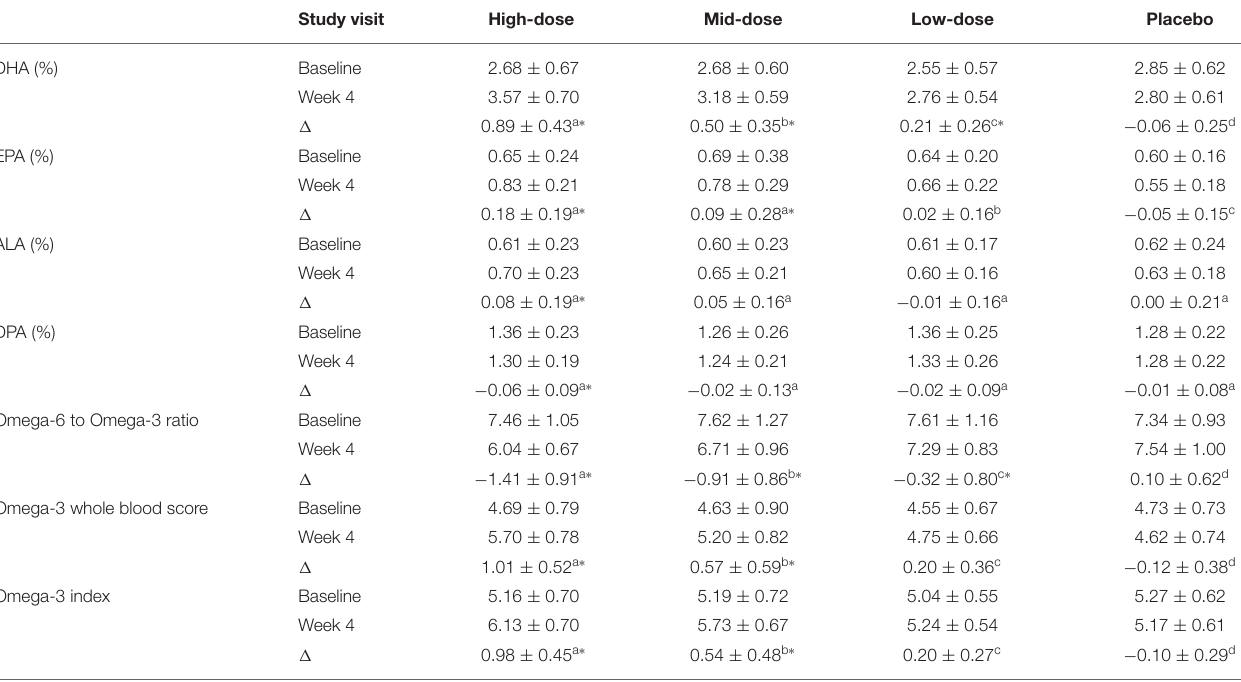
TABLE 4 | Whole blood ω 3 profile before and after the 4-week supplementation of LC- ω 3-rich canola oil or placebo. Study visit High-dose Mid-dose Low-dose